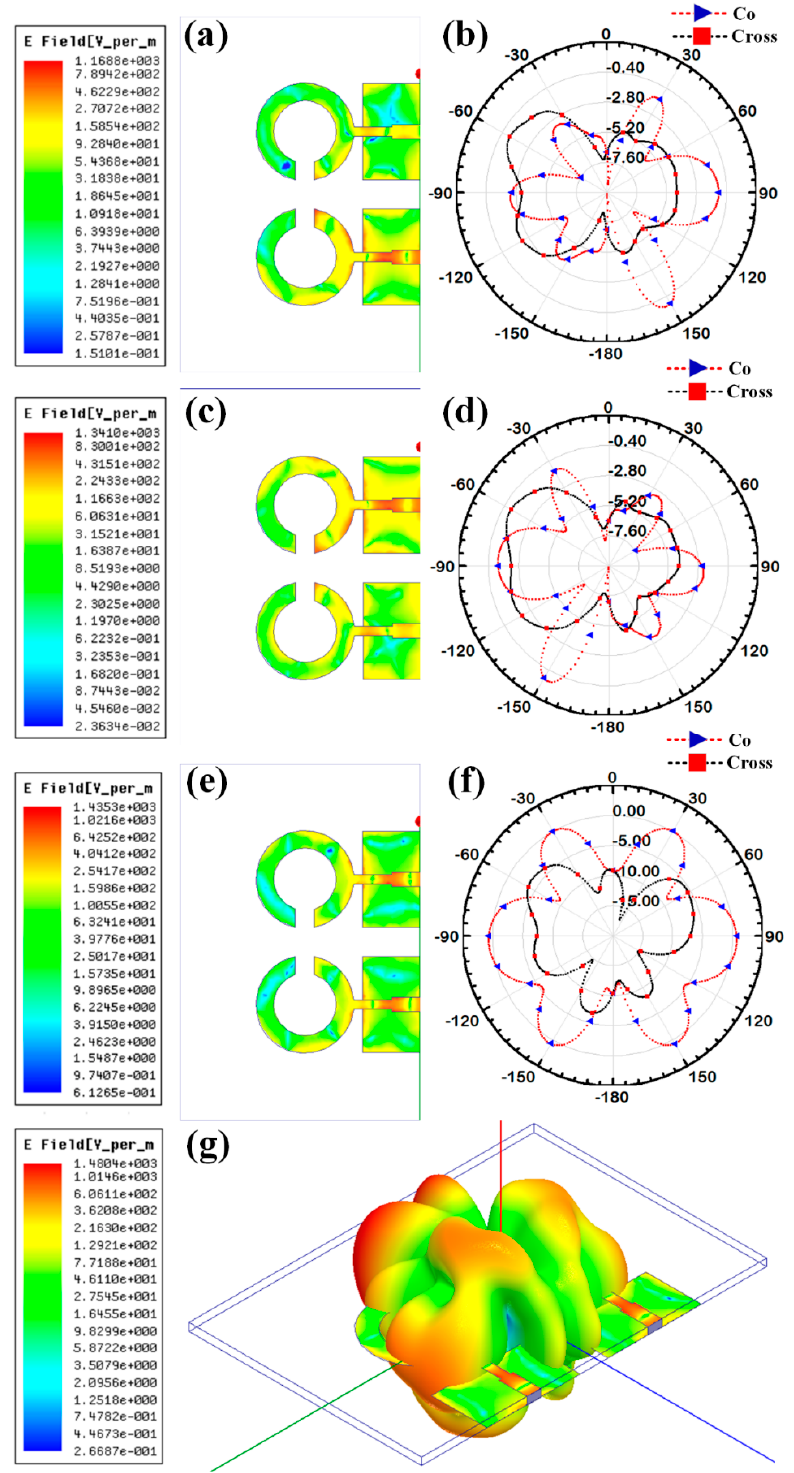
Figure 7. Electric fi eld intensity and polar radiation pa tt ern for the Design 1. Normalized electric fi eld distribution for the di ff erent port excitation conditions such as ( a ) (P1 = 0, P2 = 1) ( c ) (P1 = 1, P2 = 0), and ( e ) (P1 = 1, P2 = 1). Co-polarization and cross-polarization 2D radiation pa tt ern for the di ff erent port excitation conditions such as ( b ) (P1 = 0, P2 = 1), ( d ) (P1 = 1, P2 = 0), and ( f ) (P1 = 1, P2 = 1). ( g ) three-dimensional radiation pa tt ern along with the electric fi eld distribution for the (P1 = 1, P2 = 1) condition.